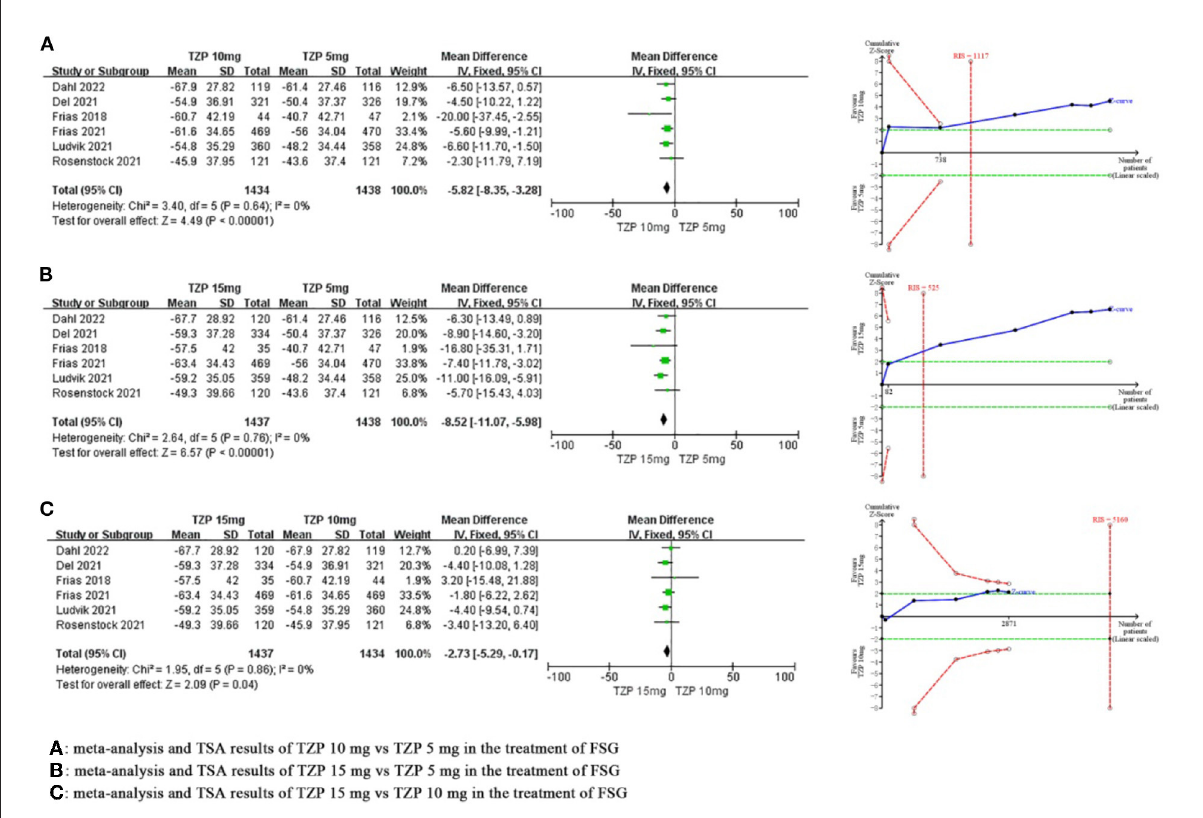
FIGURE4 Meta-analysis and TSA results of different doses of TZP for